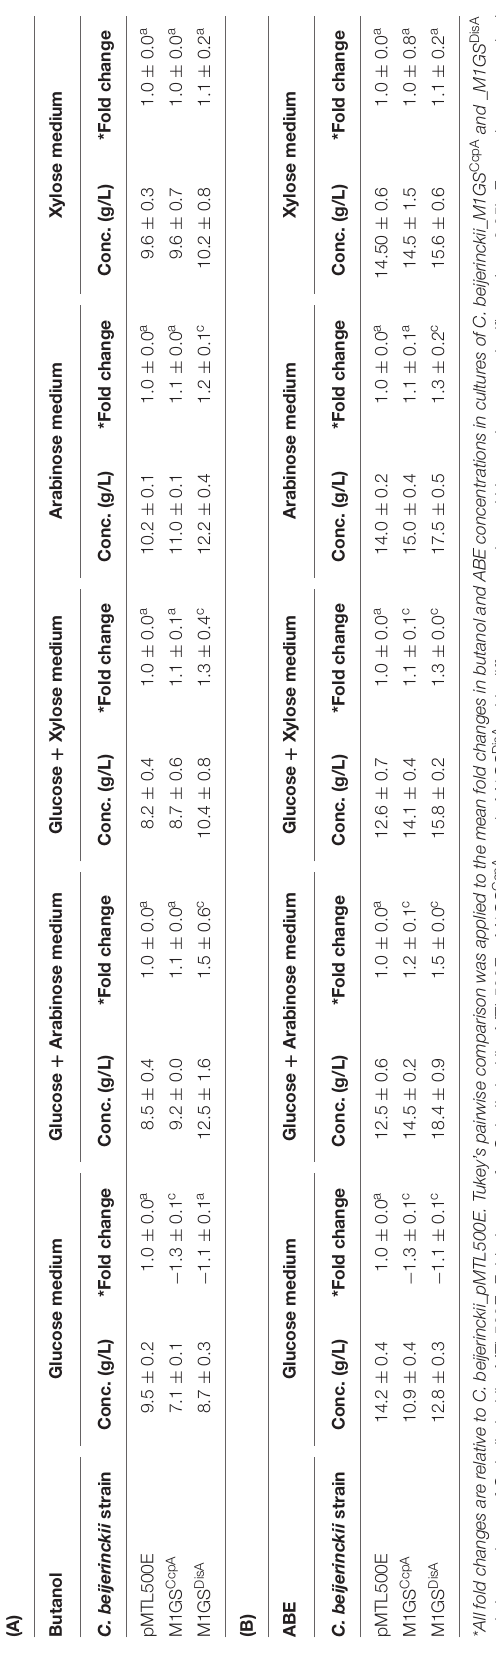
Figure 1 ). At 120 ng/mL of mitomycin C, the viability of M1GS DisA decreased by 99.9% ( p < 0.05). A similar effect was observed with nalidixic acid, which decreased the viability of C. beijerinckii _M1GS DisA by 99.8% ( p < 0.05) at 470 ng/mL and by 100% at 480-495 ng/mL. These results indicate that C. beijerinckii _M1GS DisA is hypersensitive to DNA- damaging